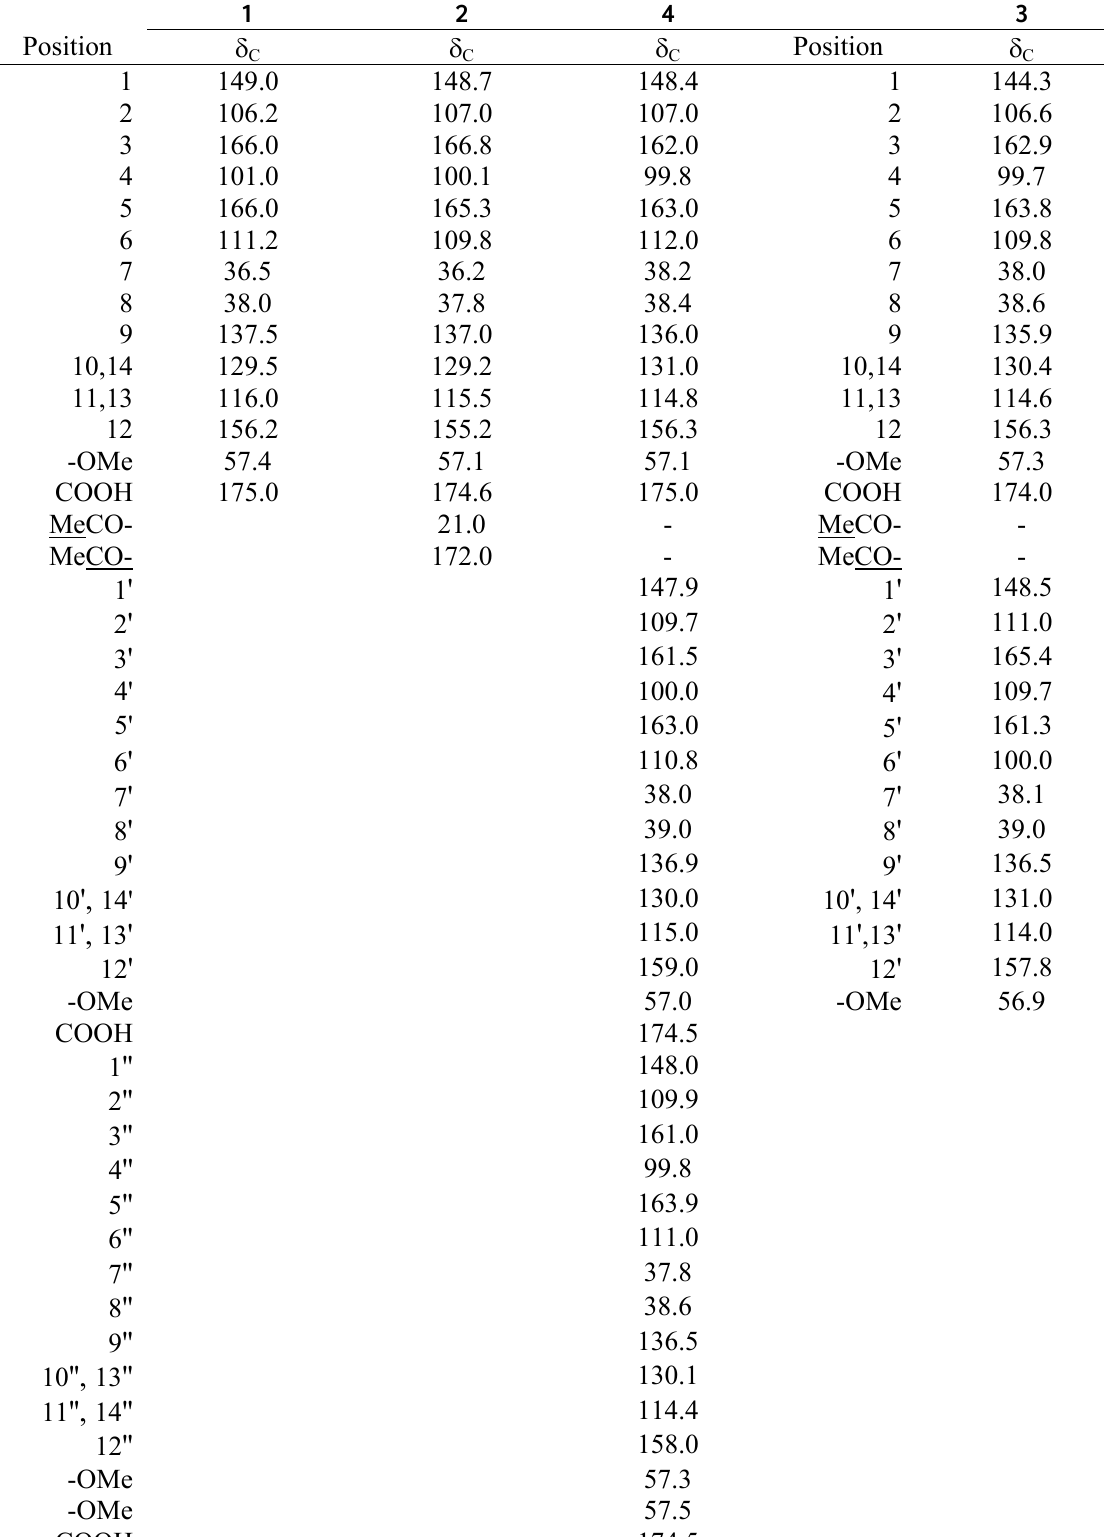
OD, 600 MHz in methanol- d 3